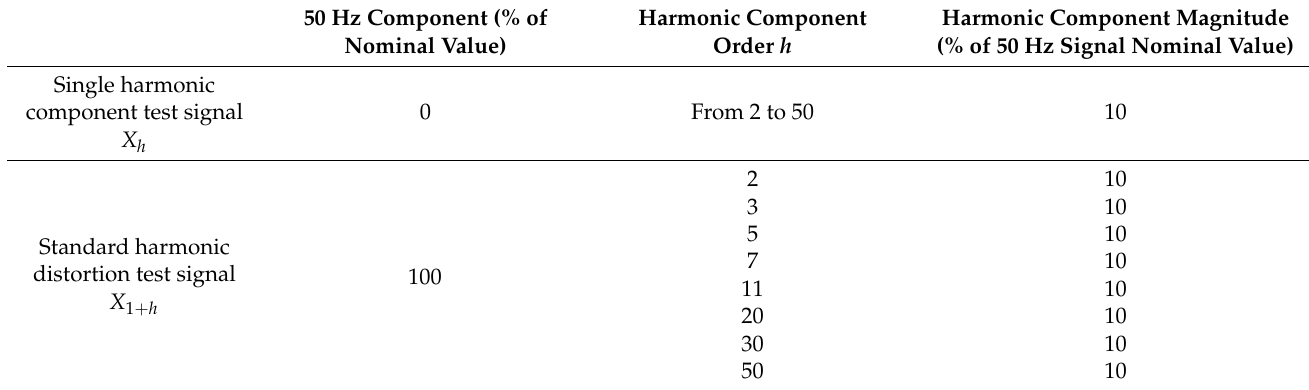
Table 4. Steady-state harmonic disturbance test